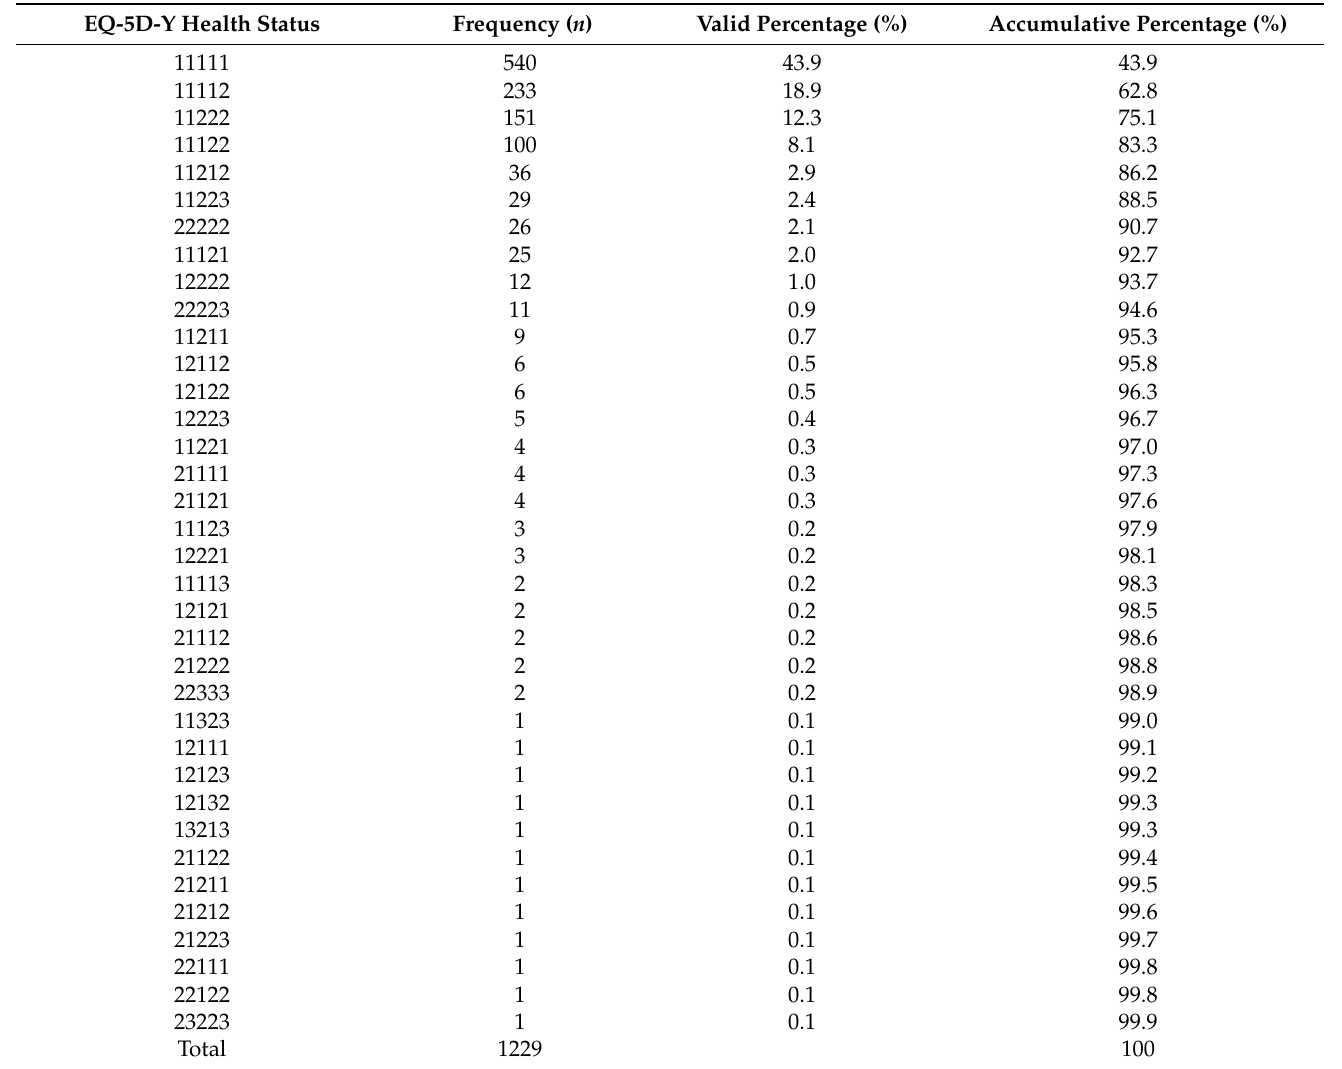
Table 4. Distribution of health